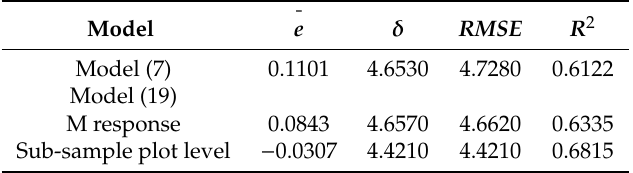
Table 4. Prediction statistics of two models using the leave-one sub-sample plot-out cross-validation ( e , mean prediction error; δ , variance of biases; RMSE , root mean square error; R 2 , coe ffi cient of determination; and M response, mean response).